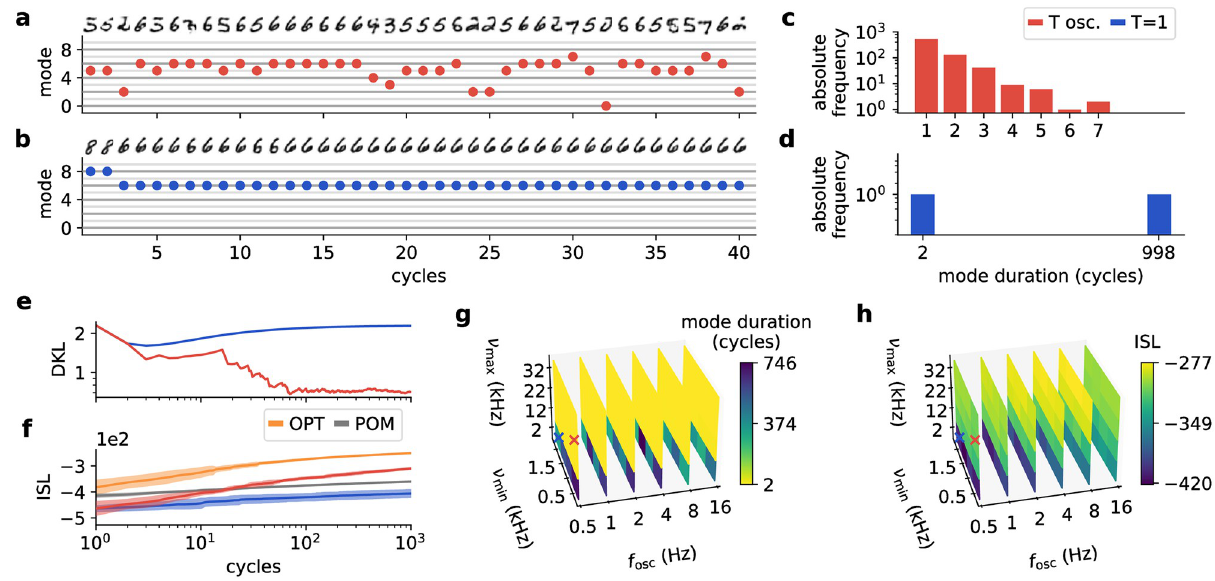
Fig 4. Parameter dependence of tempering effectiveness. (a, c) Visible and label layer activity of an LIF network trained on the MNIST dataset, with (b,d) showing the corresponding mode duration distributions (the active mode corresponds to the image class and is determined by the most active label neuron). The network with oscillatory background (red) moves quickly between modes, with correspondingly short mode durations, whereas the network with constant background activity (blue) switches to the “6” mode after two samples and remains there until the last of the 10 3 collected samples. (e) Kullback-Leibler divergence (DKL) between the distribution of sampled modes and the uniform distribution. The sampled distribution quickly becomes significantly more uniform for the oscillatory (red) compared to the constant (blue) background. (f) Indirect sampling likelihood (ISL) as a measure of image quality and diversity for the two background settings and, for orientation, for the optimal sampling (OPT, orange) and the product of marginals (POM, gray). Under this measure, the averaged MNIST images described by the POM are more similar to the entire dataset than the near-unimodal distribution generated under constant background at T = 1. Similarly, the network with oscillatory background needs several samples to produce a distribution that is diverse enough to overtake the POM. The mean (solid lines) and standard deviation (shades) over 10 runs of 10 3 samples are plotted. (g) Average mode duration for different oscillation parameters: The peak background rate ν max represents the most critical parameter and needs to be high enough to enable good mixing. The minimum background rate ν min and the oscillation frequency f osc are less important. (h) Same as (g) for the ISL values. The image quality remains consistently high across a wide range of parameter configurations. The data used for (a-f) corresponds to the simulations marked by the red and blue crosses, respectively. Values represent averages over 10 runs of 10 4 samples.